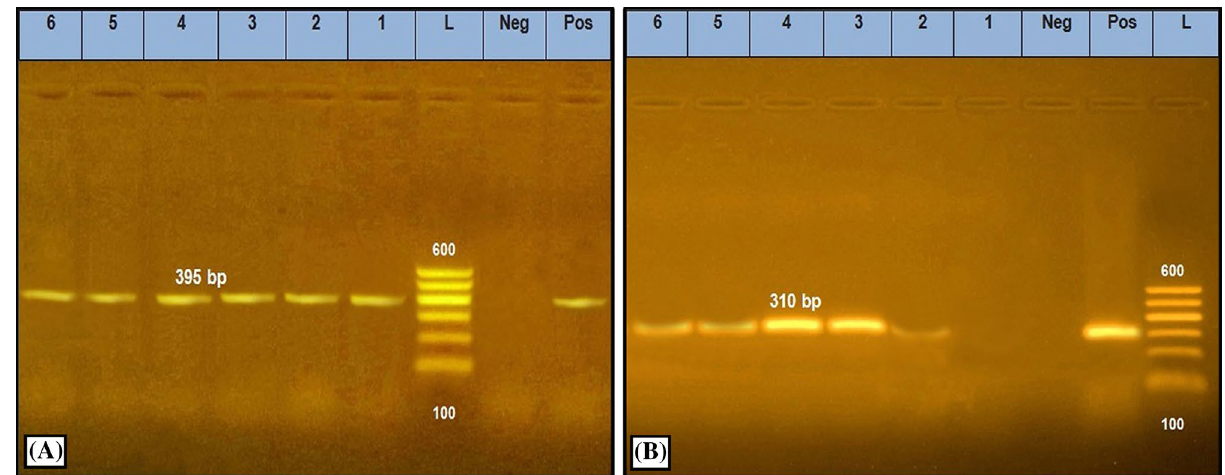
Figure 1. PCR amplification specific for S. aureus isolates on Nuc ( A ) and Mec A ( B ) genes amplified 395 bp, and 310 bp, respectively. Lane (L): 100 bp Ladder ’’Marker’’, Lanes (1–6): examined samples, Lane Pos: Positive control, Lane Neg: Negative